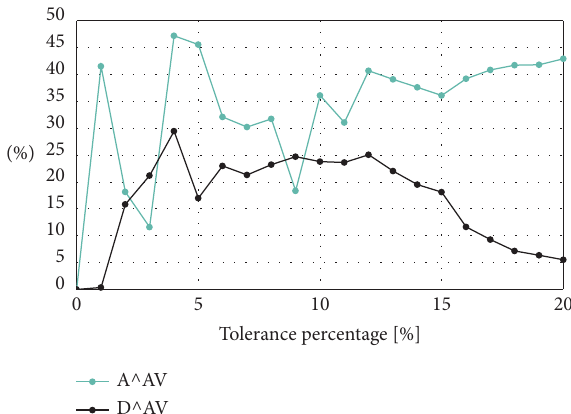
Figure 8: Cost per probability of failure for the diferent tolerance levels. Table 7: Variation of the fve performance indicators regarding the use of time window tolerances.